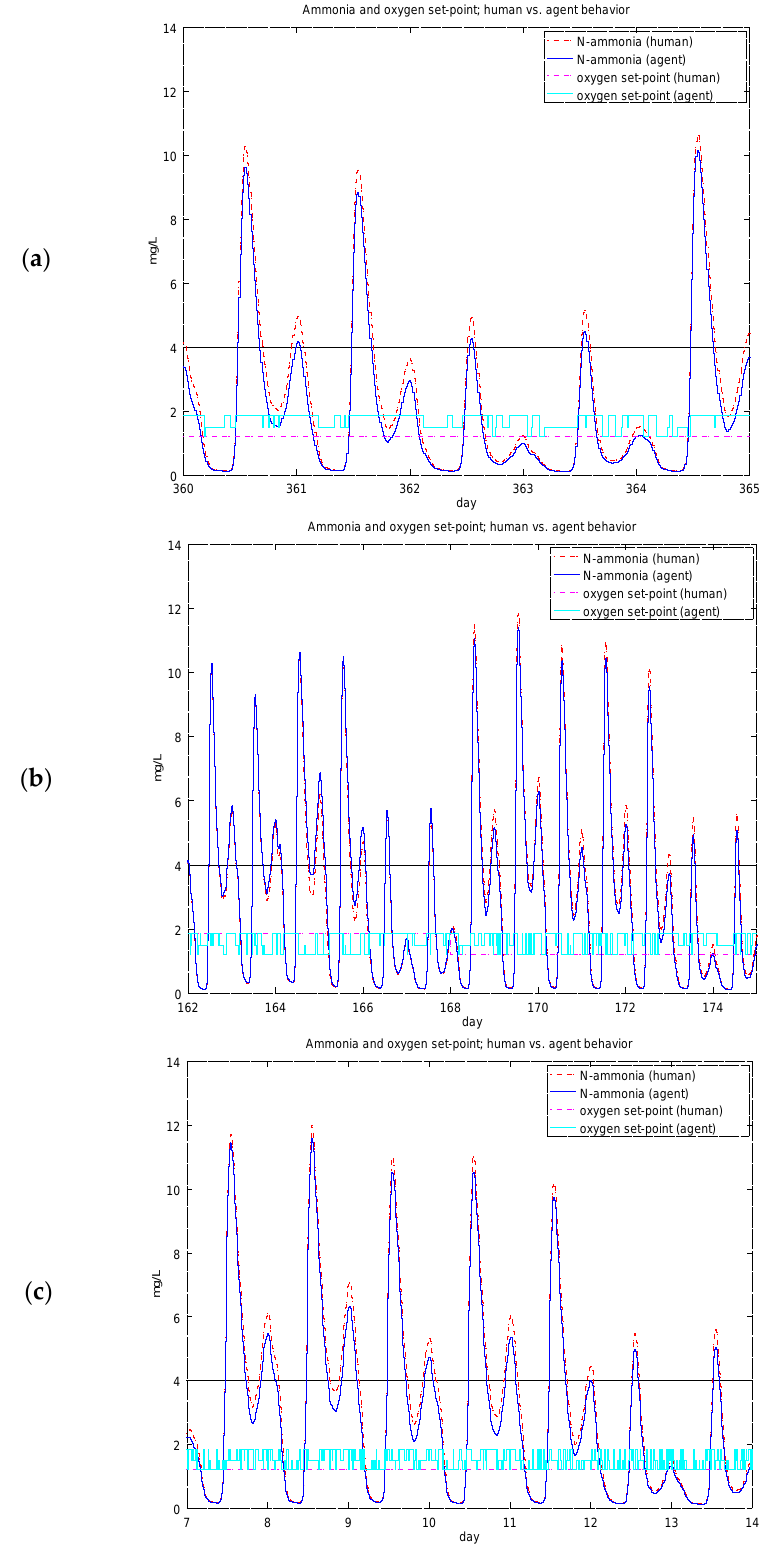
Figure 8. Human operator’s behavior vs. RL agent’s behavior throughout the first year: ( a ) last days; ( b ) days in the middle; and ( c ) first days.